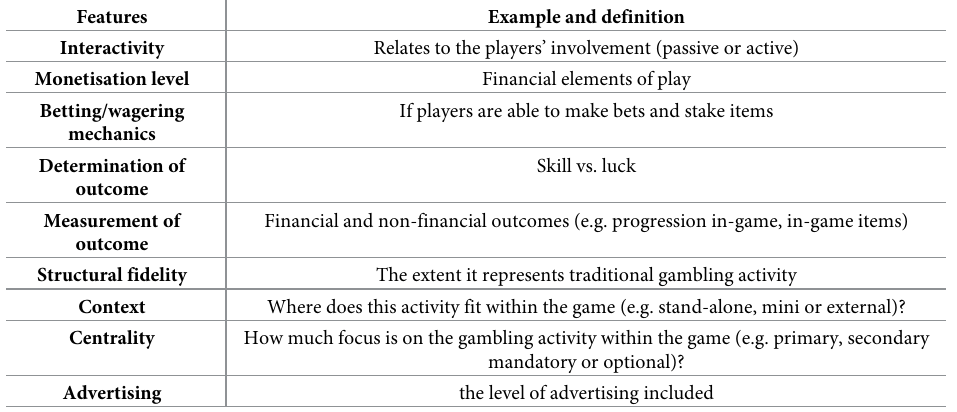
Table 1. King et al. [43] description, definition, and examples of gambling features in